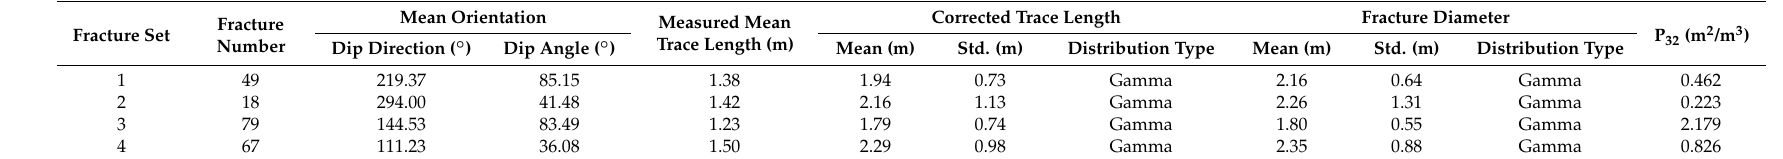
Table 1. Parameters for the 3D fracture network modeling.